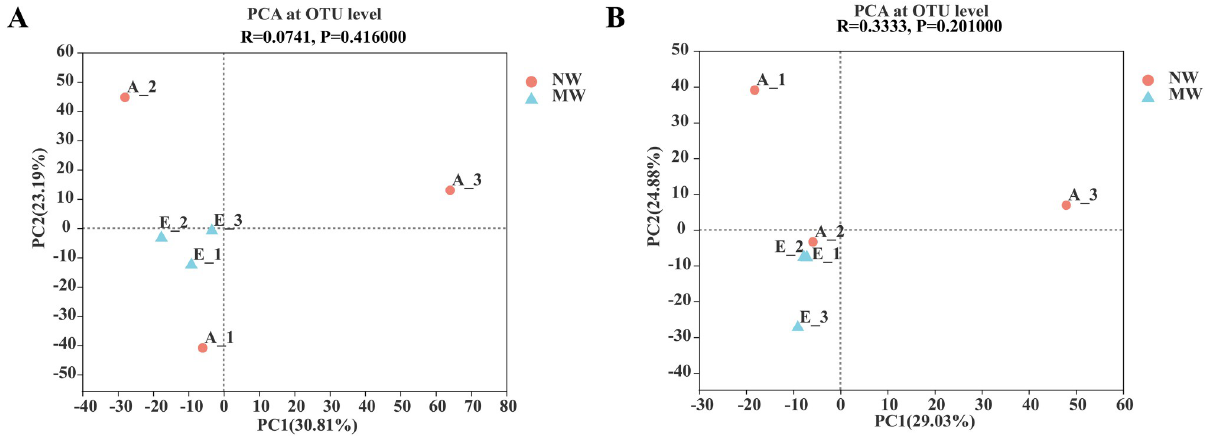
Fig 1. PCA of soil bacterial (A) and fungal (B) communities in star anise plantations between the NW and MW treatments (OTU level). Note . NW: no weeding in the star anise plantation, and MW: mechanical weeding in the star anise plantation. ANOSIM analysis was used to test differences between